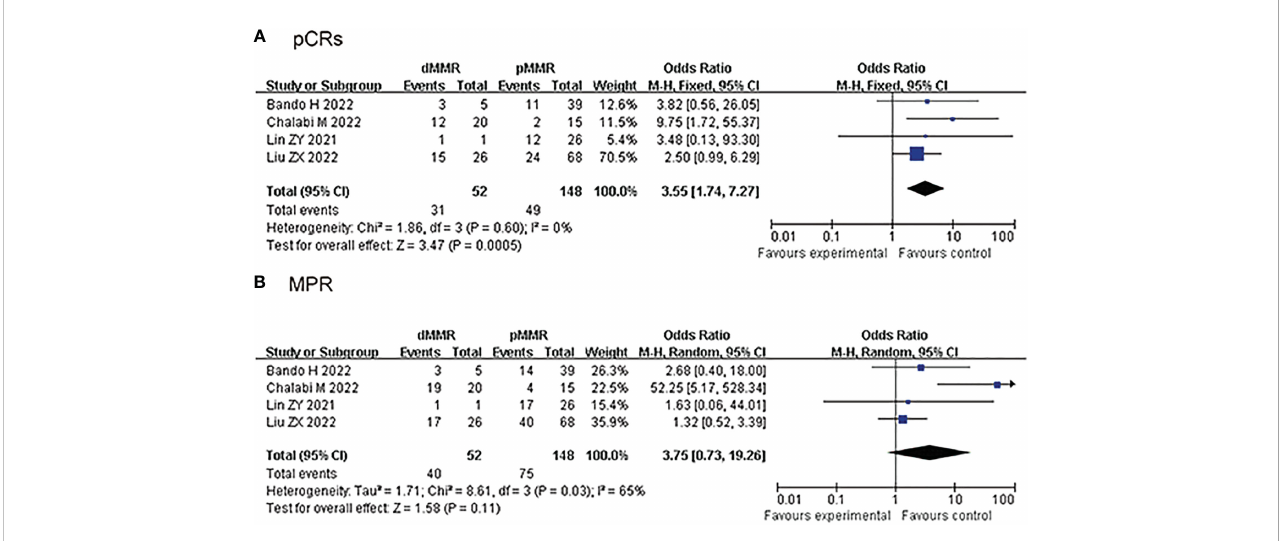
FIGURE 3 Secondary outcomes of neoadjuvant immunotherapy for non-metastatic colorectal cancer. (dMMR/MSl-H vs pMMR/MSS group). (A) pathological complete response (pCRs); (B) major pathological response (MPR).